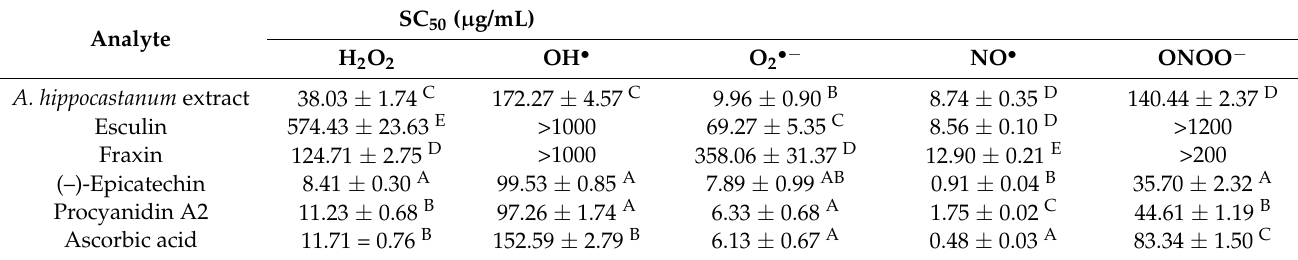
Table 2. Scavenging activity of the dry methanol extract from the bark of A. hippocastanum and its main constituents towards selected reactive oxygen species.